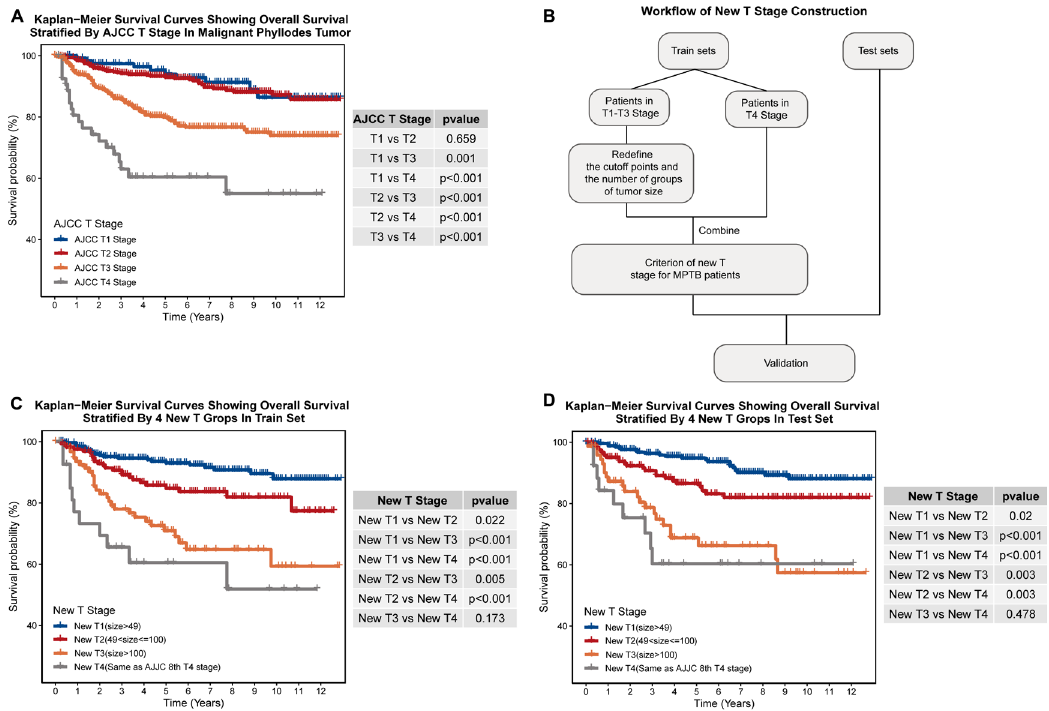
Figure 2. Construction of new T-staging system for MPTB. ( A ) Kaplan–Meier plot showing overall survival stratified by AJCC T stage in MPTB. ( B ) Workflow for the construction of new T-staging system for MPTB. ( C ) Kaplan–Meier plot showing overall survival stratified by new T stage in training set. ( D ) Kaplan–Meier plot showing overall survival stratified by new T stage in test set.